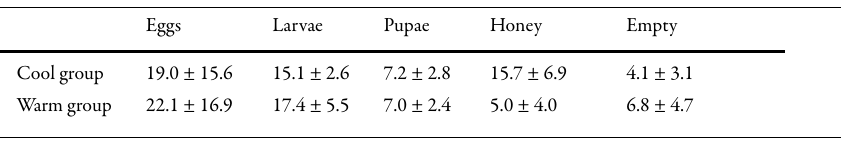
Table 1. Mean (± SD) number of contents in the cells in cold ( N =5) and warm ( N =5) condtion observed at the end of pre-emergence period.